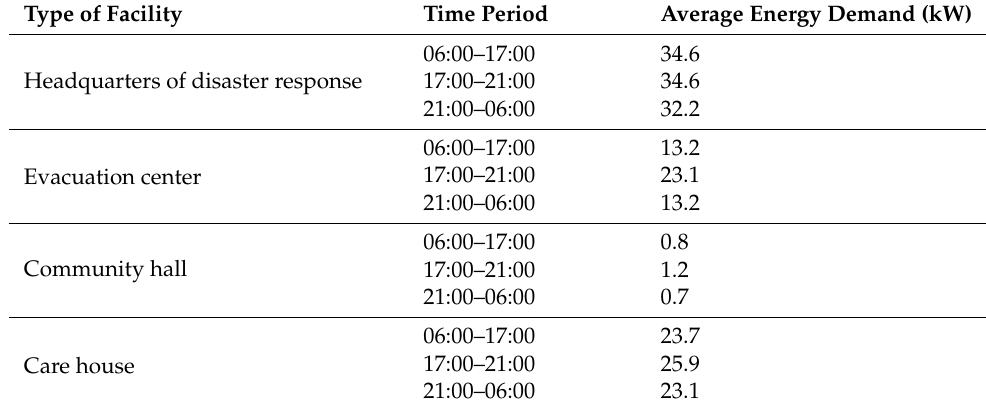
Table 2. Energy demand by time of day in typical resilience facilities.